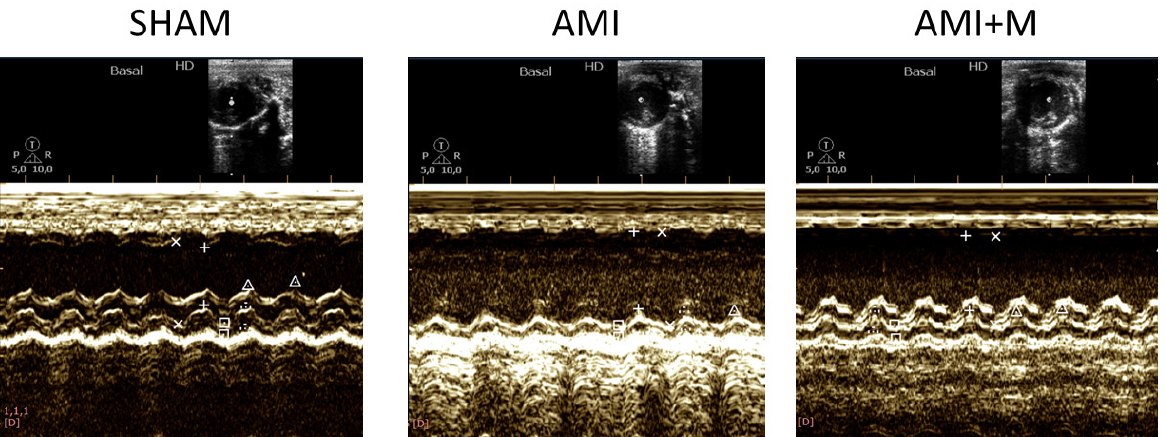
Figure 1. Representative M-mode echocardiographic images from the basal view left ventricle 56 days after